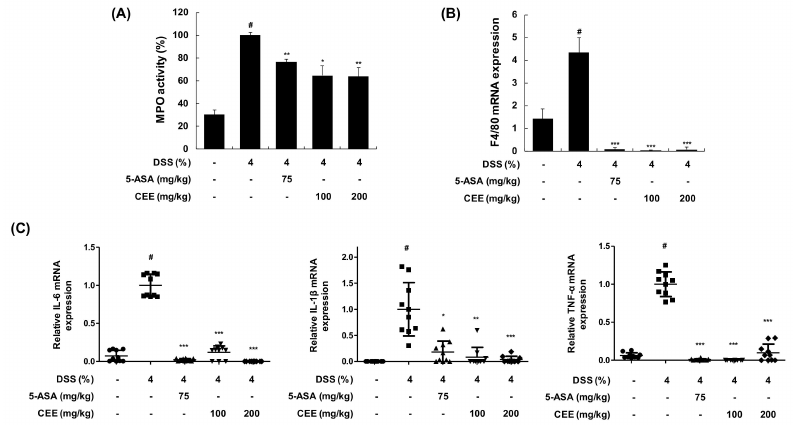
Figure 5. E ff ects of CEE on inflammatory response in mice with DSS-induced colitis. After administration with or without CEE (100 or 200 mg / kg / day p.o.) for 9 days, ( A ) colon tissues from mice were used to determine MPO activity. ( B , C ) The mRNA expression was determined by qRT-PCR from DSS-fed intestinal colon tissue. Using specific primers, the mRNA expression of ( B) F4 / 80 and ( C ) IL-6, IL-1 β , and TNF- α was determined and normalized to β -actin expression. Data are presented as mean ± SDs ( 0 10). # p < 0.001 vs. the control group; * p < 0.05, ** p < 0.01, *** p < 0.001 vs. the DSS-fed colitis group.